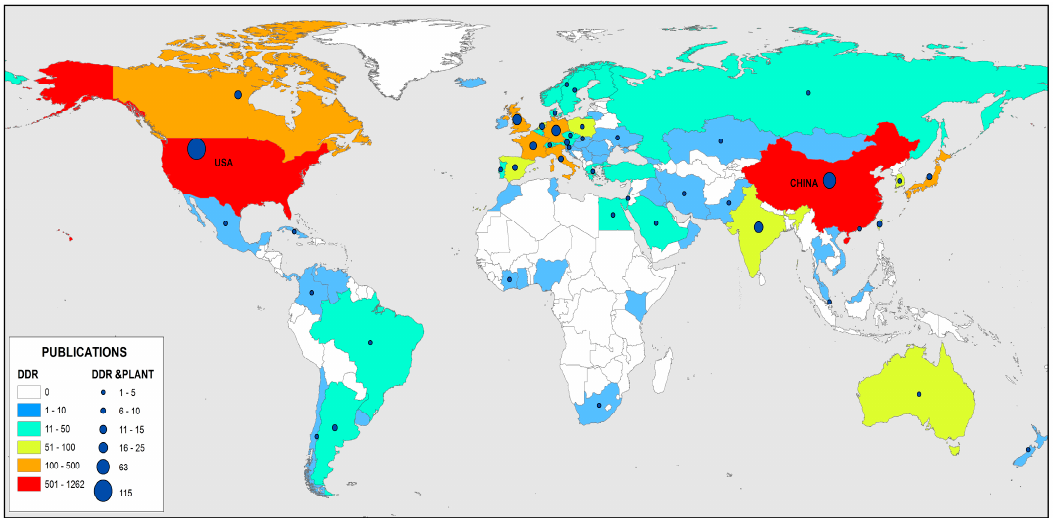
Figure 3. Worldwide research on DDR and DDR&Plant during the period 1970–2016. Table 4. Languages of scientific output in the DDR research field and DDR research in the plant field.